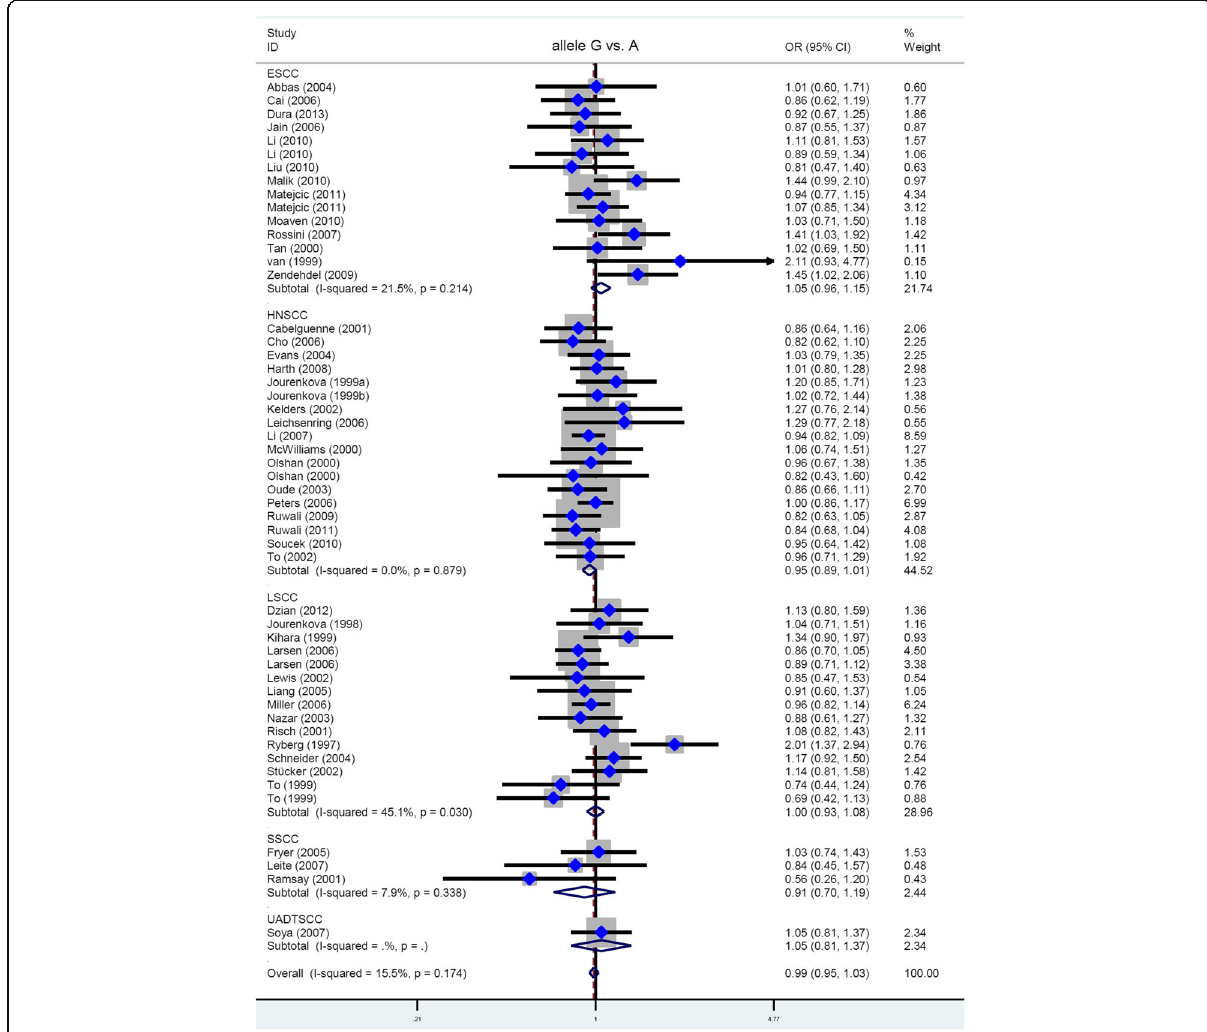
Fig. 2 Data of subgroup analysis by SCC type (allele model)